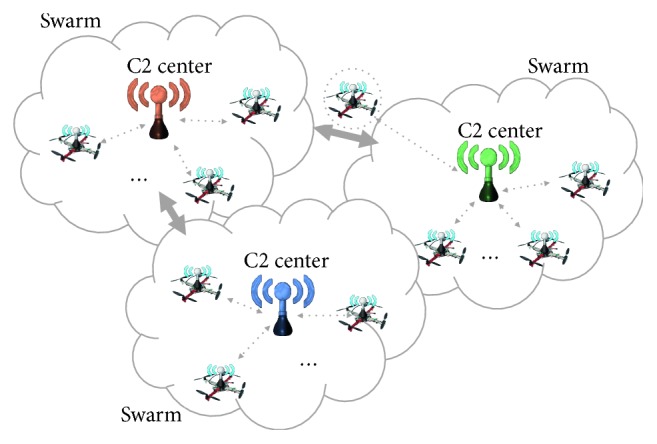
Cluster scale model.